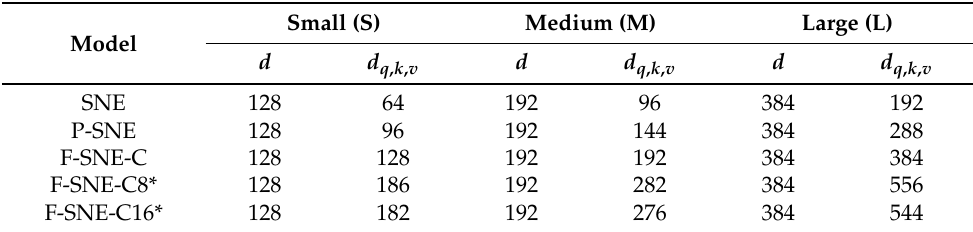
Table 1. Corresponding output dimensions of Q , K , and V embedding layers to each model variant are listed